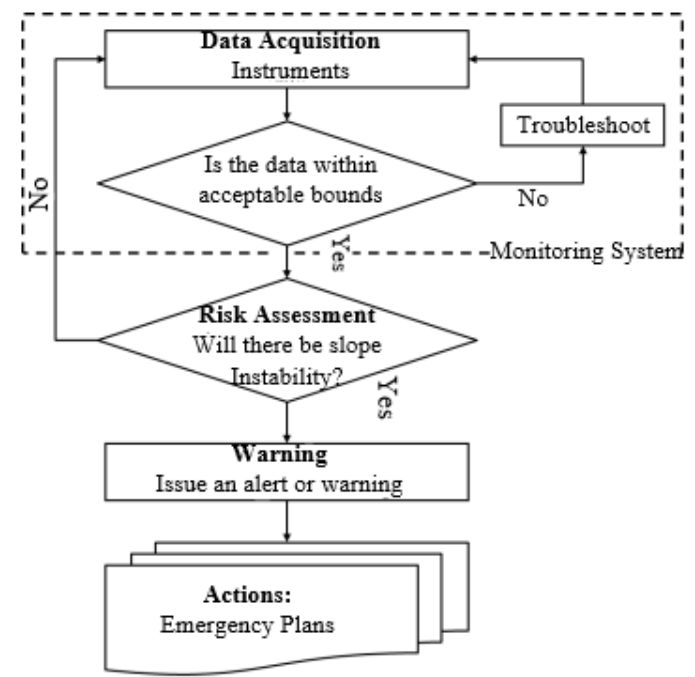
Figure 17. The flow chart for early warning system (Adapted from [140]).